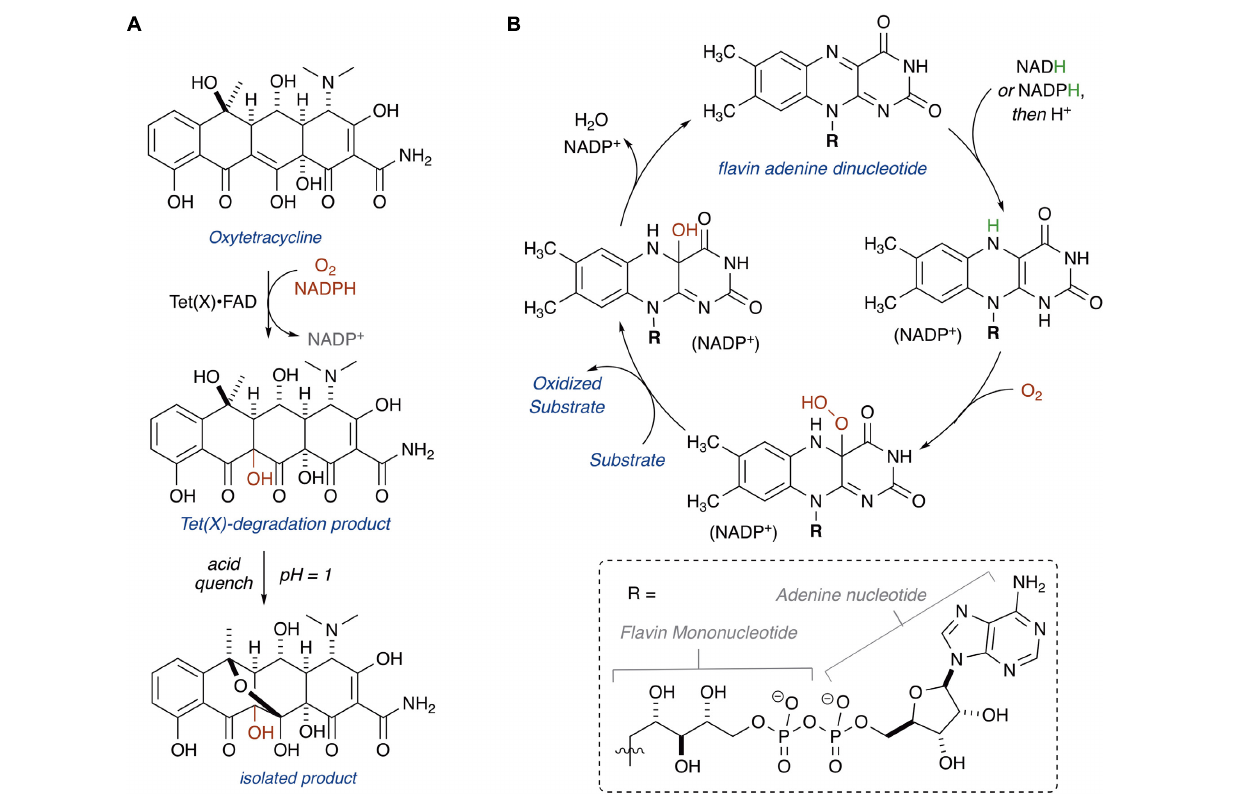
Frontiers in Microbiology |